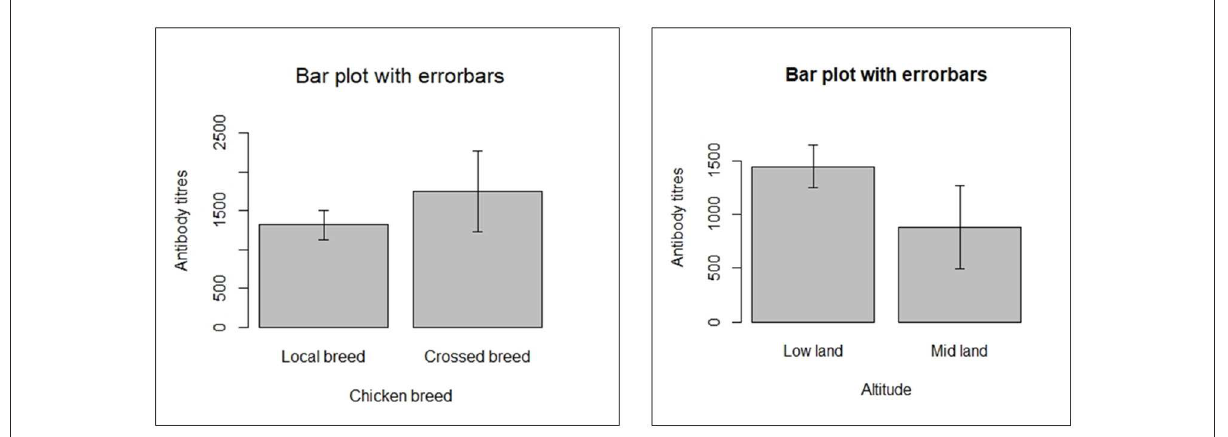
FIGURE2 Comparison of antibody response in different chicken in breeds.